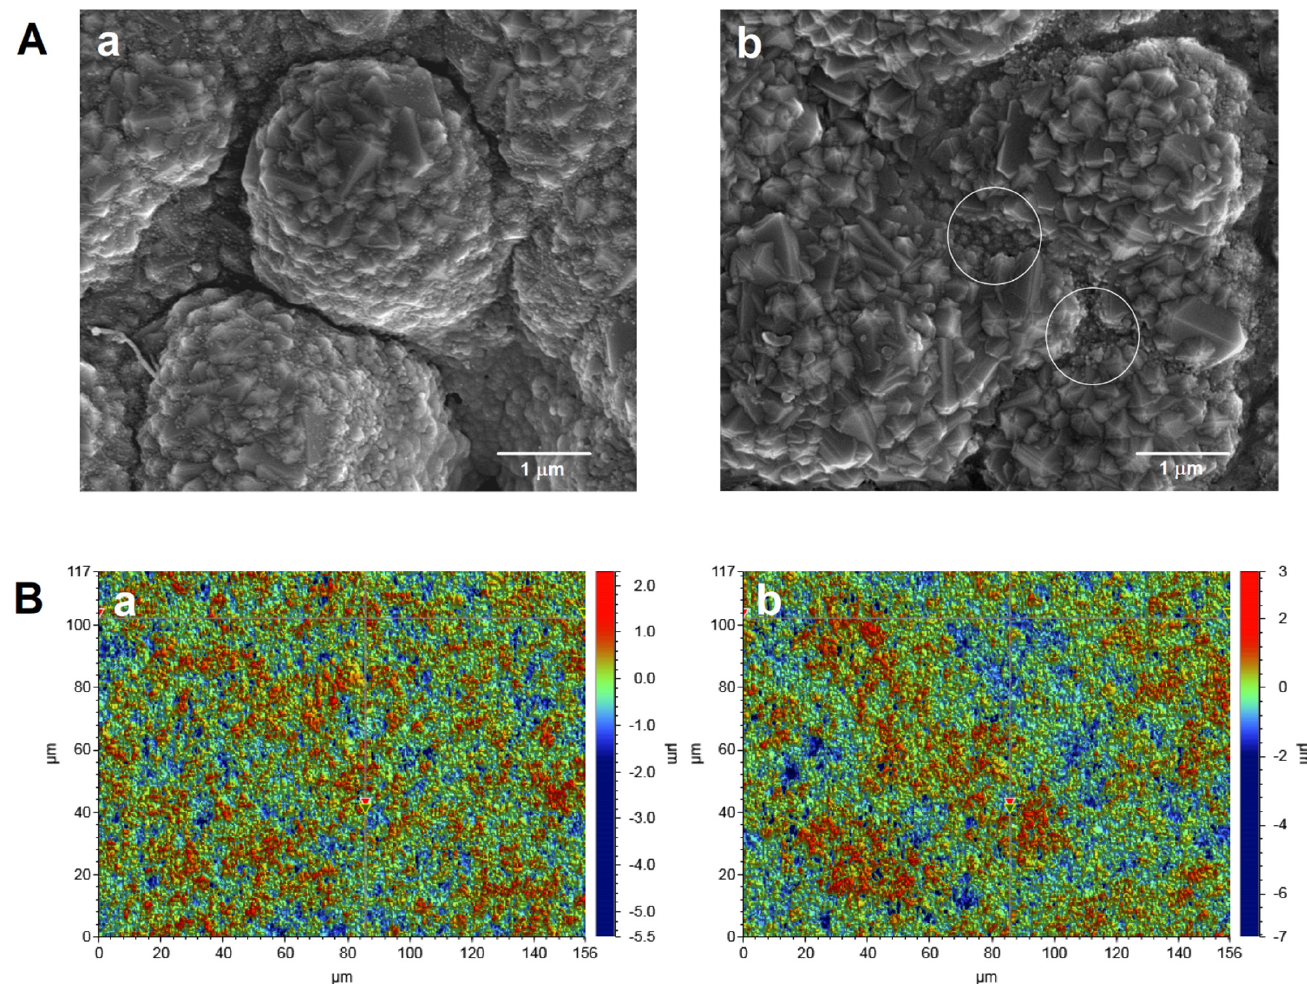
Figure 3. ( A ) Scanning electron microscope (SEM) images and ( B ) optical profiles of SPBDDE (a) and aSPBDDE (b).